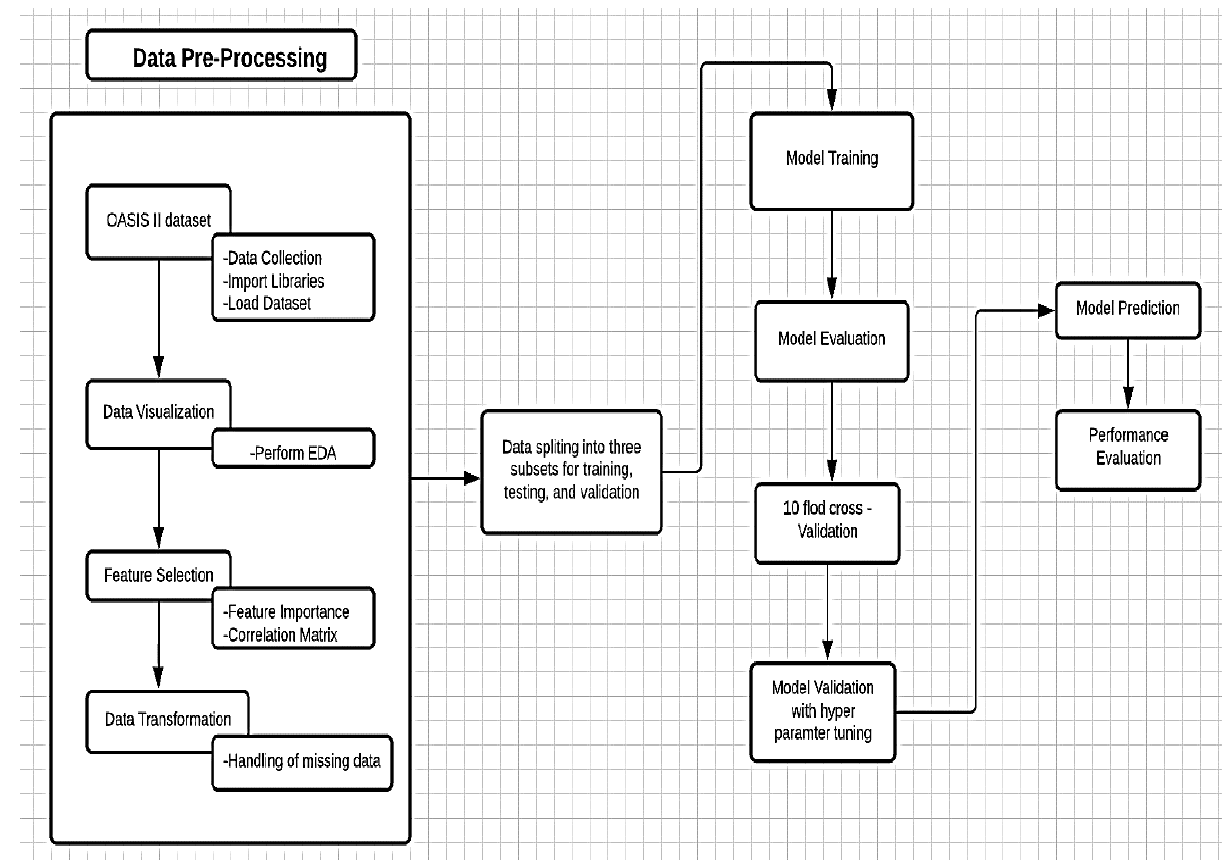
Figure 1. Experimental setup for the proposed model.